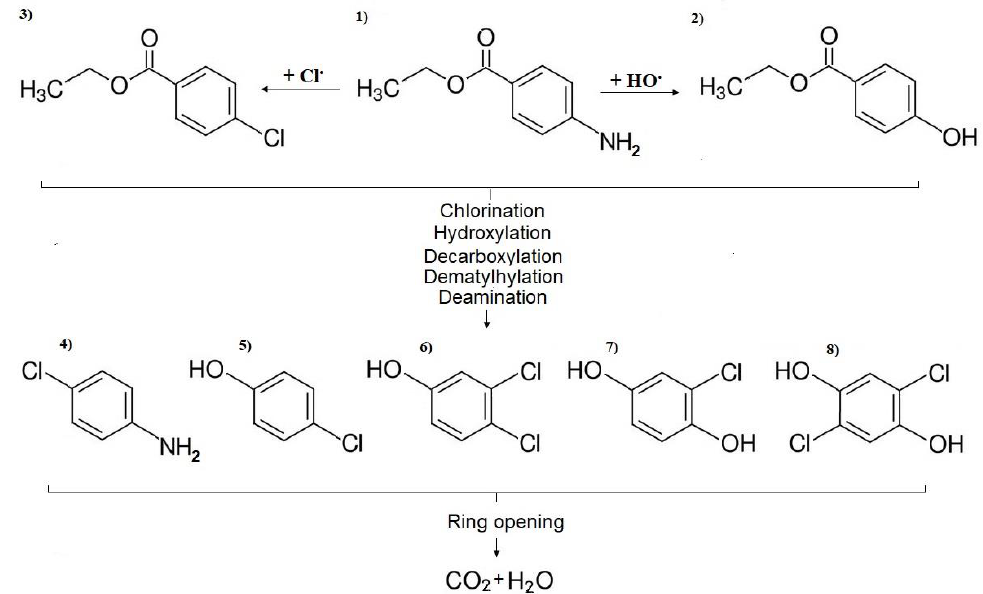
Figure 6. Possible decomposition of ( 1 ) BE with the identified intermediates ( 2 ) Ethyl 4-hydroxybenzoate, ( 3 ) Ethyl 4-chlorobenzoate, ( 4 ) 4-Chloroaniline, ( 5 ) 4-Chlorophenol, ( 6 ) 3,4-Dichlorophenol, (7) Chlorohydroquinone, and ( 8 ) 2,5-Dichlorohydroquinone.